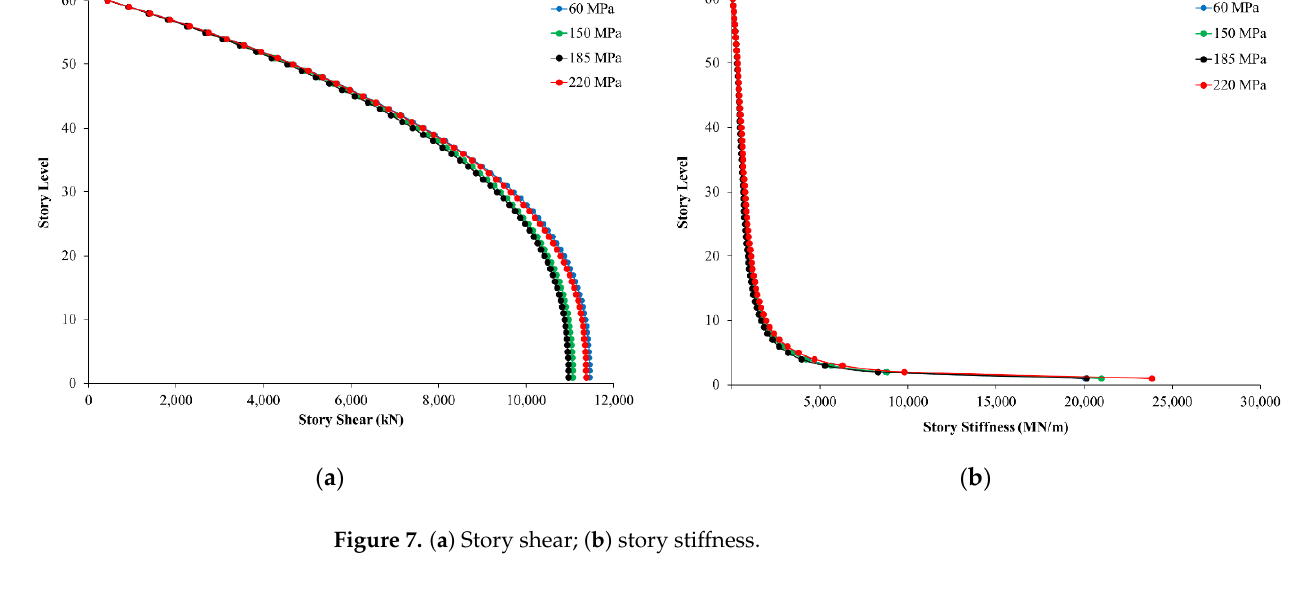
Table notations: L be (boundary element length), b be (boundary element thickness), A s,H,L (horizontal reinforcement in long direction), A s,H,S (horizontal reinforcement in short direction).